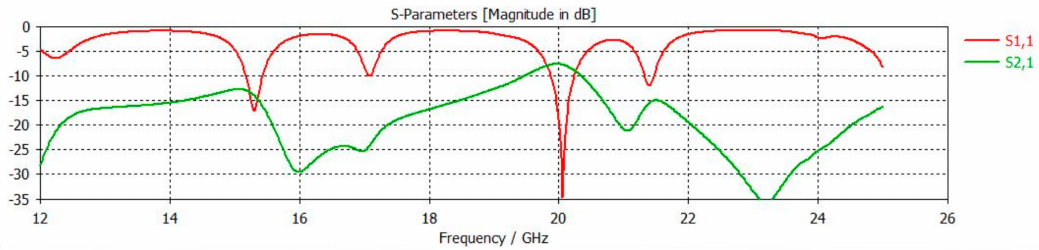
Figure 3. S parameters found after simulation for the model (for FR4